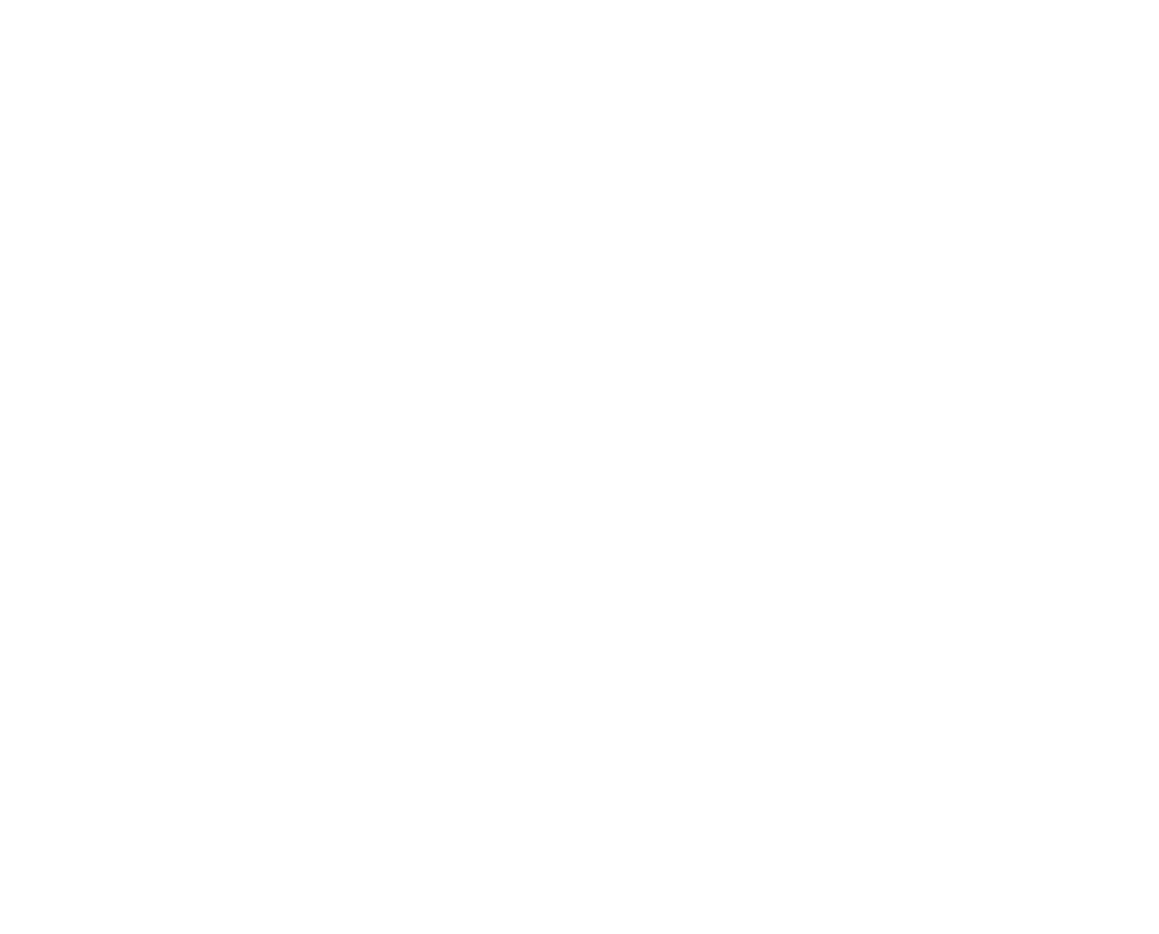
Private school Public school Raven Raw TOL Raven Raw TOL score score score score Mean SD Mean SD Mean